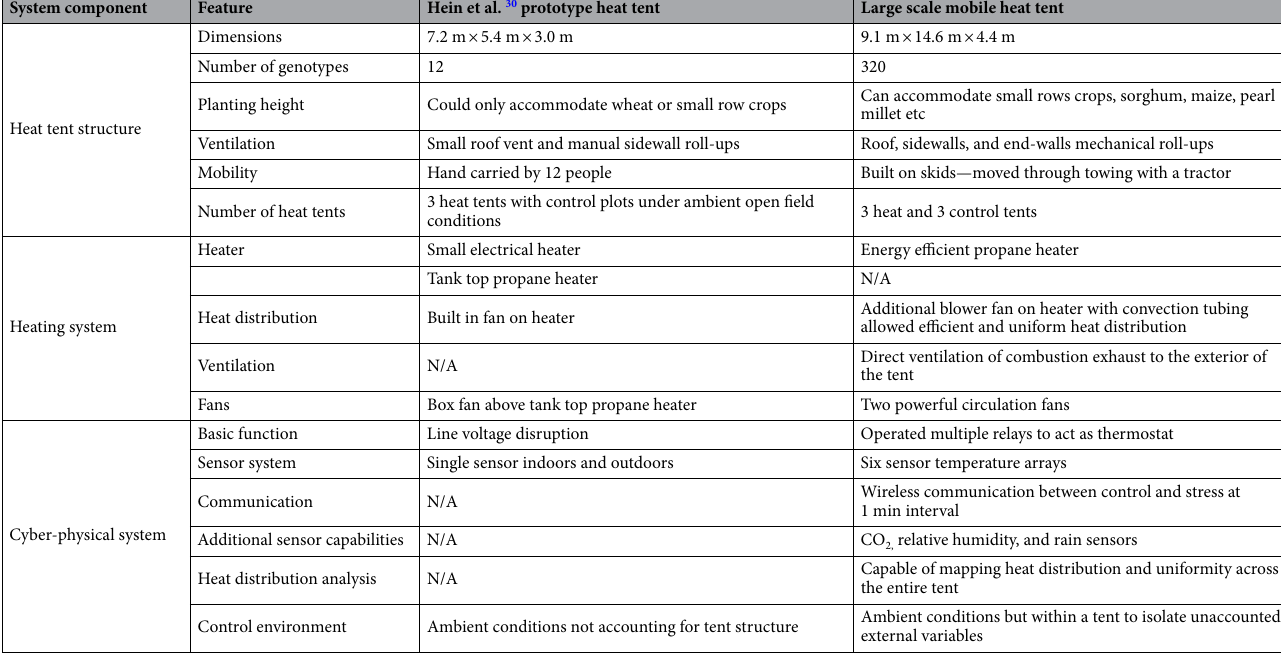
Table 1. Improvements in large scale field-based heat tents and cyber-physical system compared to the prototype presented in Hein et al. 30 , for phenotyping impact of high night-time temperature stress. N/A—Not